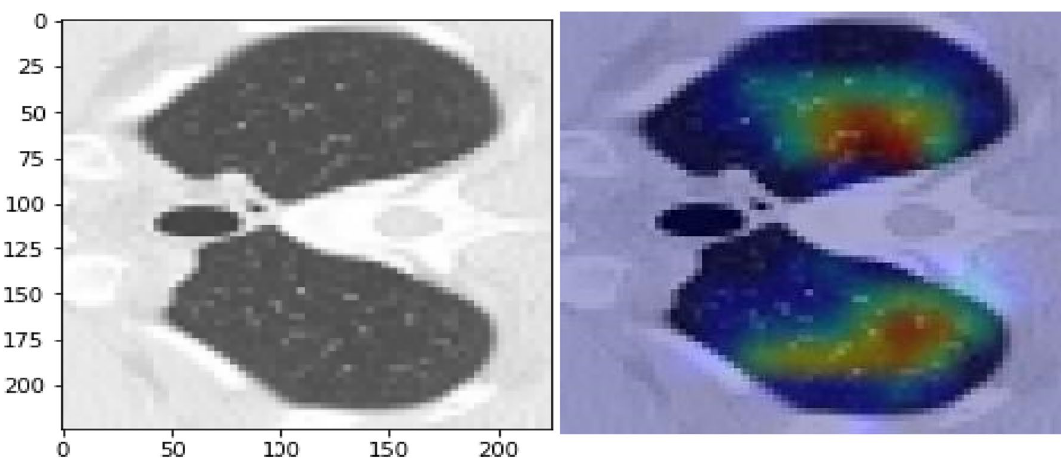
Figure 5. Grad-CAM of proposed model—Heatmap for Covid